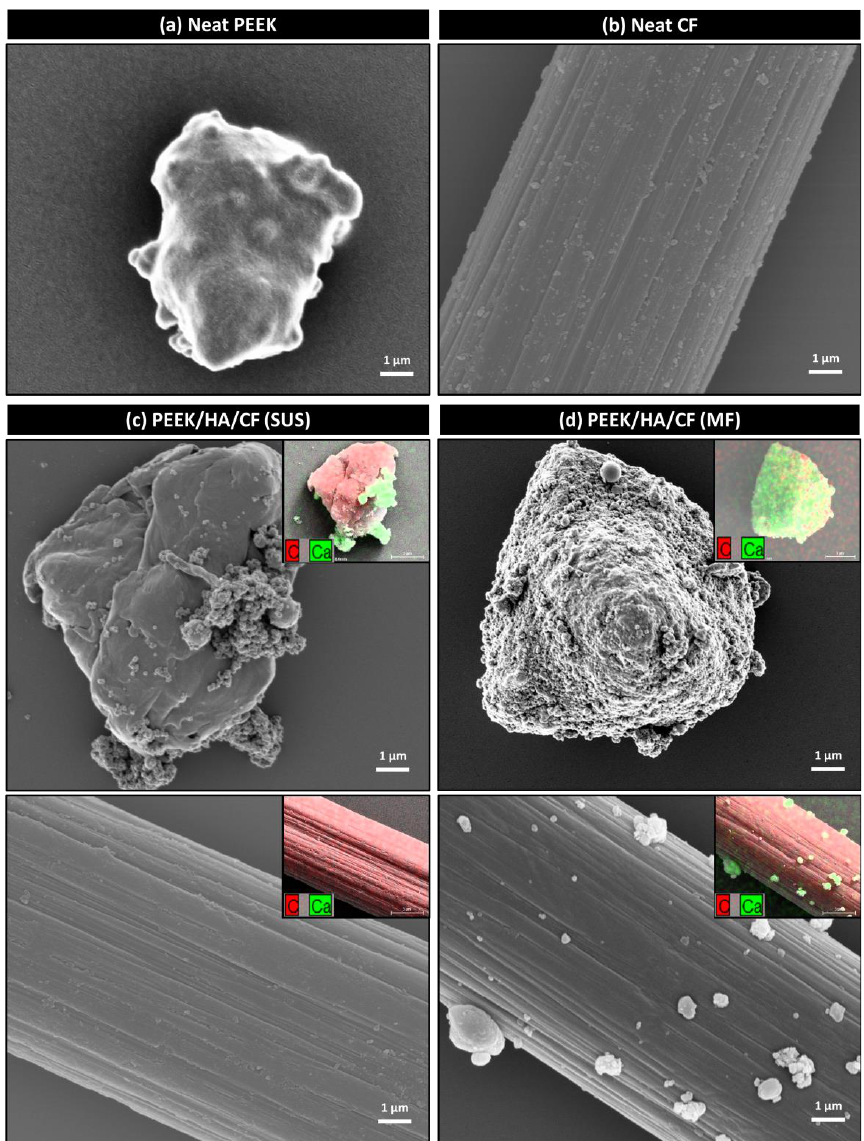
Figure 2. SEM images of ( a ) PEEK and ( b ) CF surfaces; SEM images and corresponding EDS